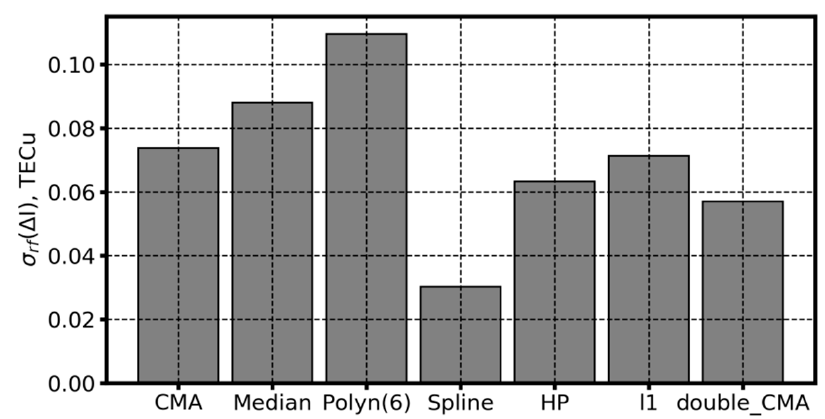
Figure 5. Root-mean square error, σ RF , for various detrending techniques.